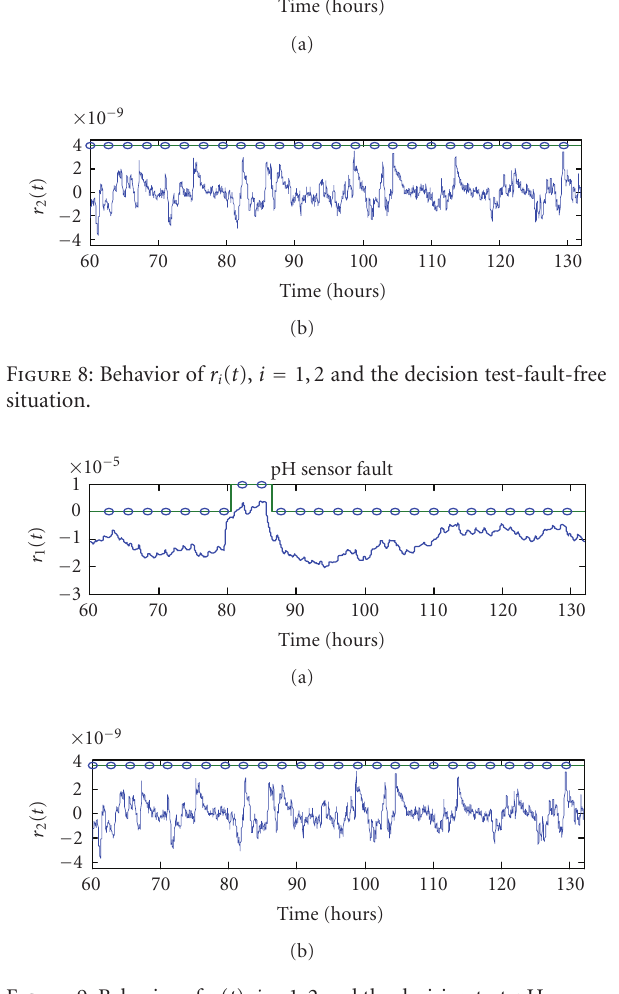
Figure 9: Behavior of r i ( t ), i = 1,2 and the decision test-pH sensor fault (80h–85 h).